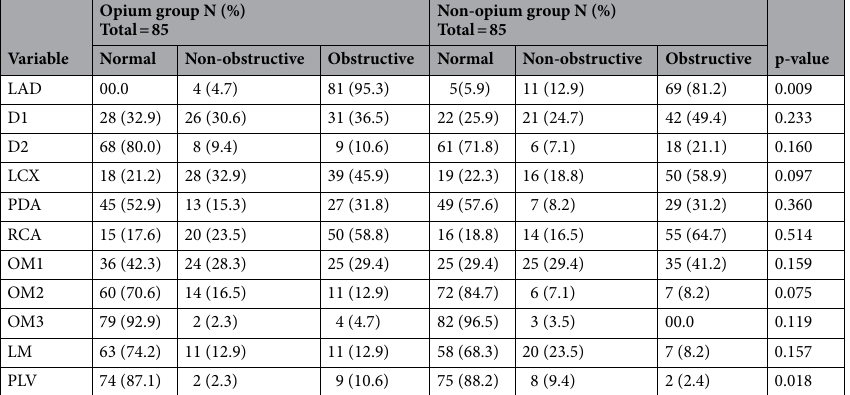
Table 2. The prevalence of obstructive and non-obstructive lesion of the vessels in the non-opium and opium groups. LAD left anterior descending artery, D1 first diagonal artery, D2 second diagonal artery, LCX left circumflex artery, PDA patent ductus arteriosus, RCA right coronary artery, OM1 first obtuse marginal artery, OM2 second obtuse marginal artery, OM3 third obtuse marginal artery, LM left main artery, PLV posterior left ventricular